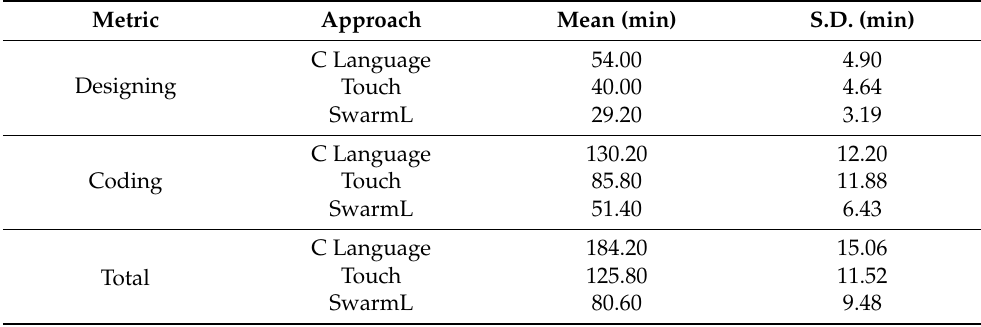
Table 3. Time spent by the